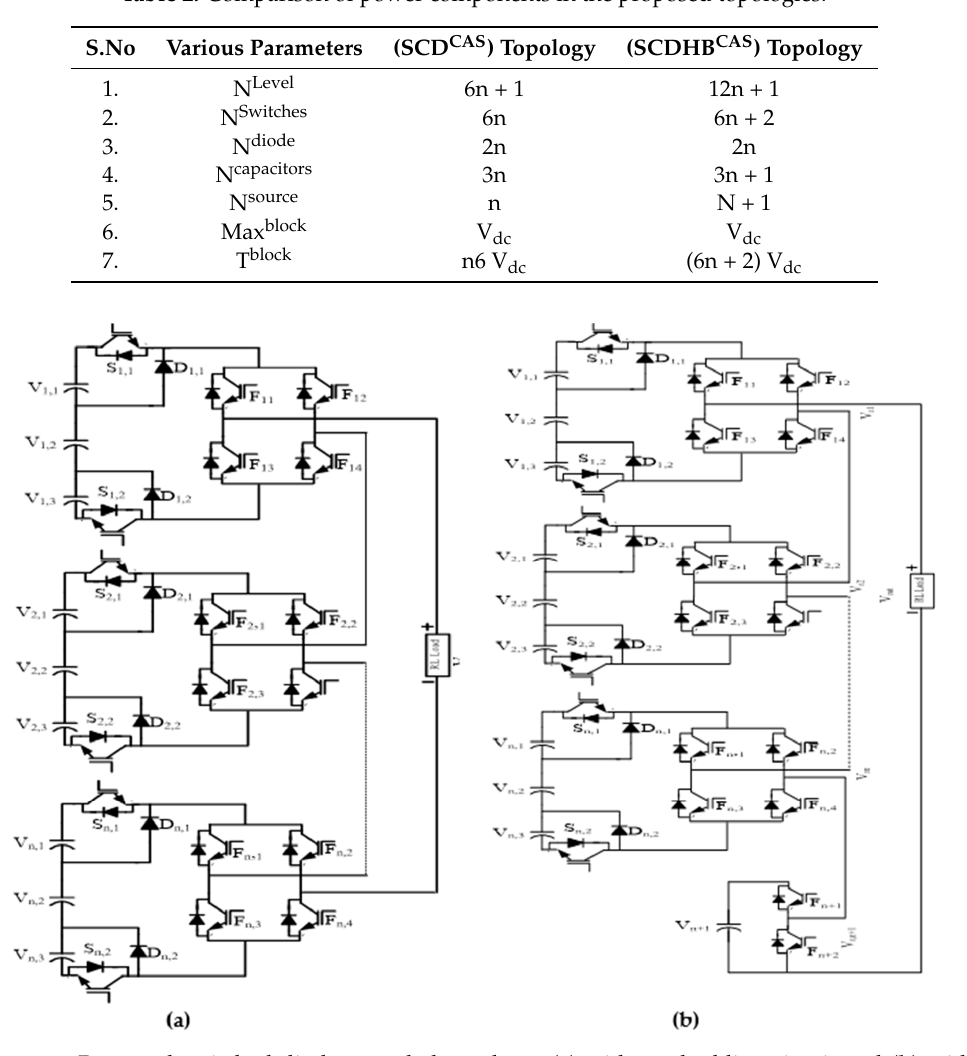
Figure 3. Proposed switched-diode cascaded topology; ( a ) without doubling circuit and ( b ) with doubling